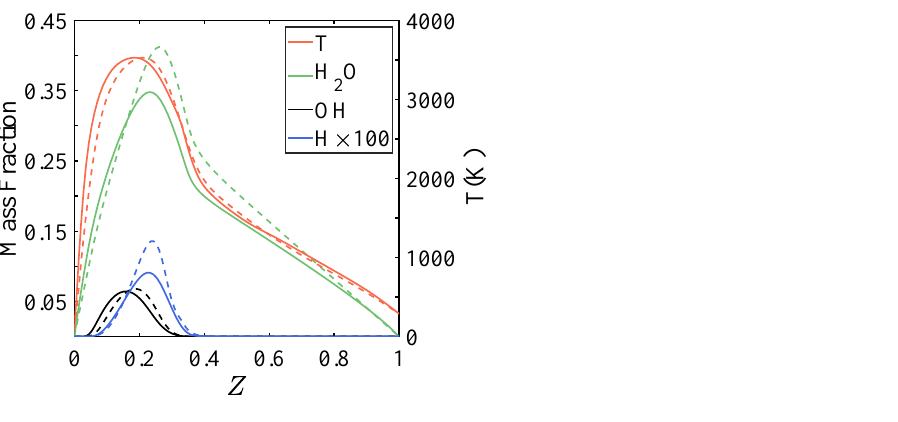
Figure 1. The contrast of laminar counterflow flames in the mixture fraction space. Solid lines: non-unity Lewis numbers; dashed lines: unity Lewis